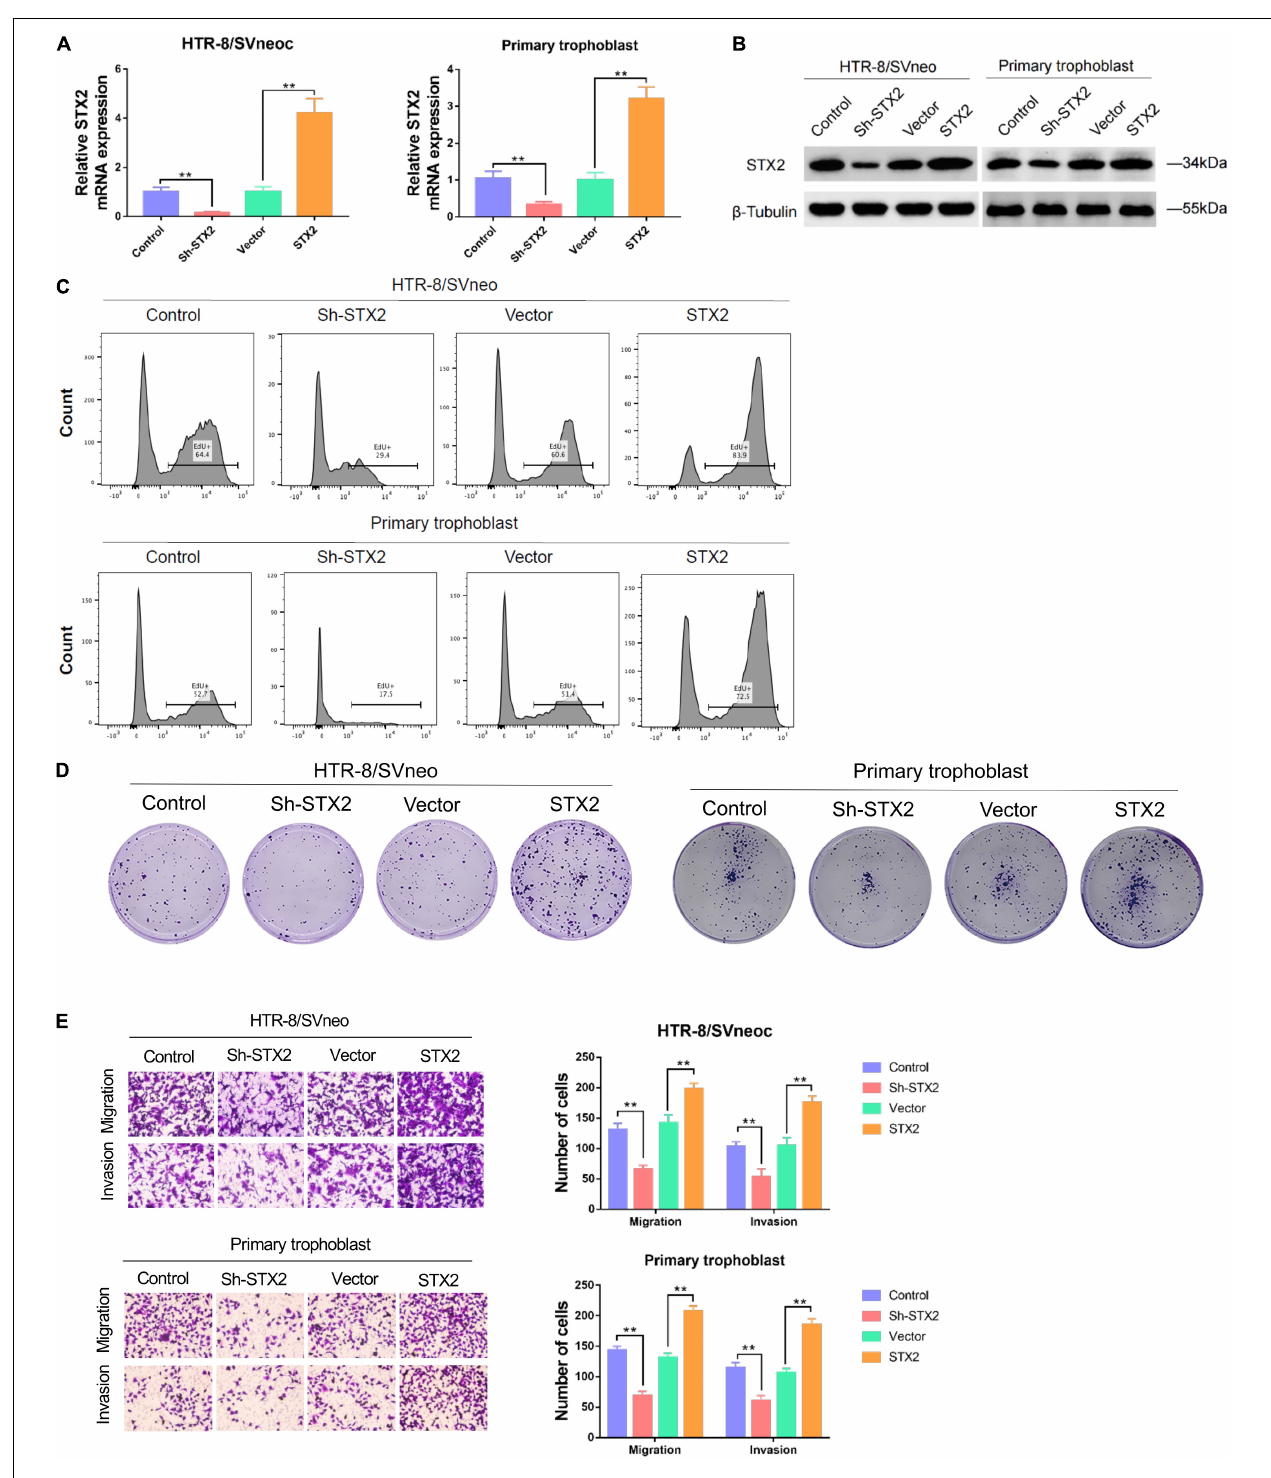
FIGURE 2 | STX2 promotes proliferation, migration and invasion of trophoblast cells. (A) qRT-PCR analysis and (B) western blot analysis of STX2 expressions in HTR-8/SVneo and primary human trophoblast cells transfected with Sh-STX2 and STX2-expressing lentivirus. (C) EdU assay and (D) colony forming assay of control and experimental cells in which STX2 was knocked down or overexpressed. Down-regulated STX2 reduced cell proliferation, whereas up-regulated STX2 increased cell proliferation. (E) Transwell assays of control and experimental cells in which STX2 was knocked down or overexpressed. Down-regulated STX2 inhibited cell migration and invasion, whereas up-regulated STX2 promoted cell migration and invasion. All the experiments were repeated three times independently. Data are represented as the mean ± SEM. Student’s t -test: ** P < 0.01.